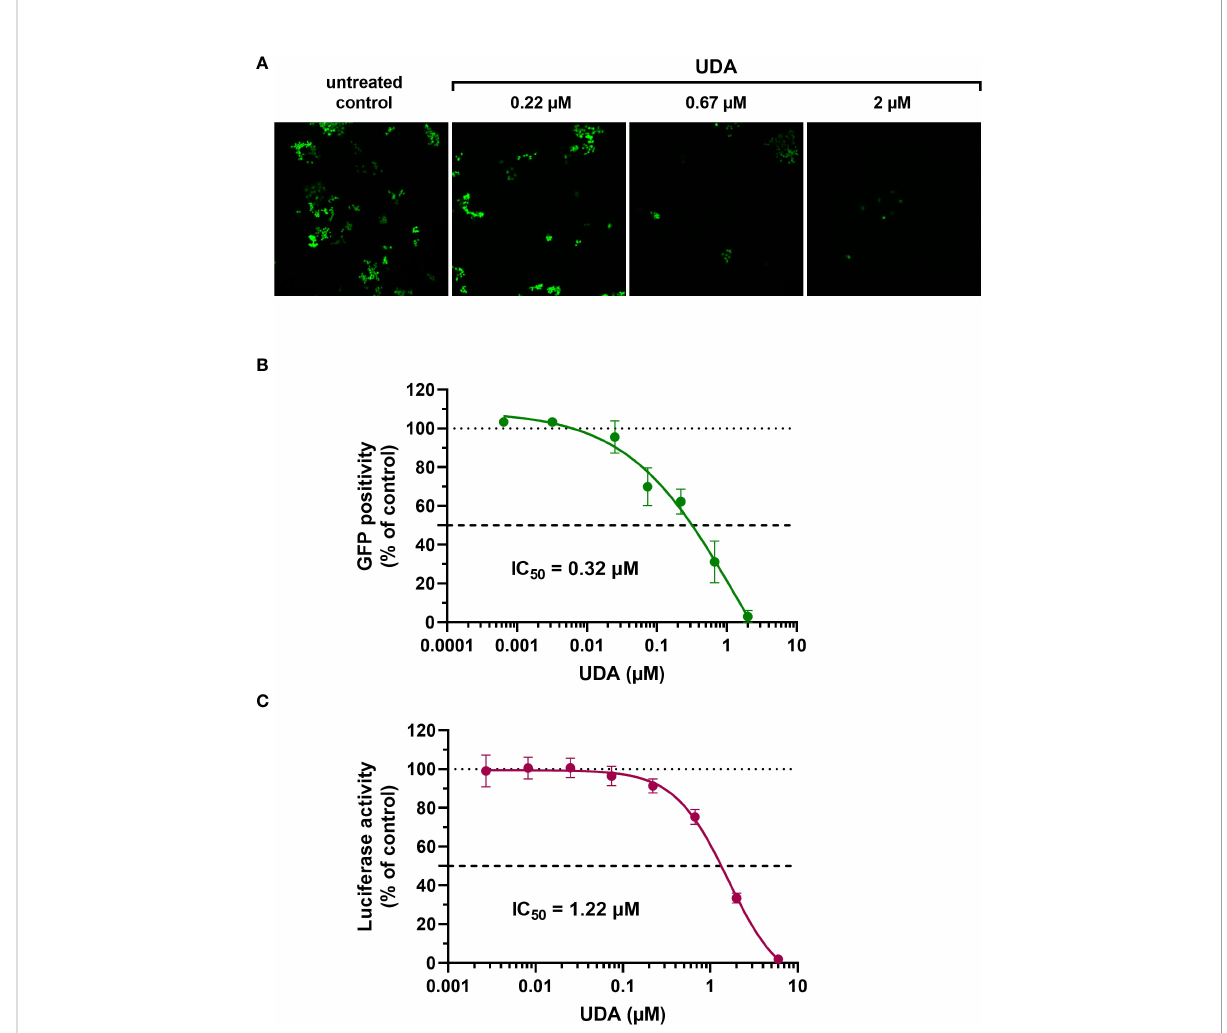
FIGURE 1 Antiviral activity of UDA against pseudotyped SARS-CoV-2. VLPs expressing the Wuhan-Hu-1 spike and a GFP or luciferase reporter was used to transduce cells in the absence (untreated control) or presence of UDA (as indicated). (A) A549.ACE2 + cells were transiently transfected with TMPRSS2 and subsequently exposed to pseudotyped SARS-CoV-2 expressing GFP. Panel shows representative images taken at 3 days post- transduction. (B) GFP-positive cells were quanti fi ed from images of (A) . Graph represents a concentration-response of UDA (mean ± SD from 3 independent experiments). (C) UDA was tested against luciferase-based pseudotyped SARS-CoV-2 in commercially available A549.ACE2 + .TMPRSS2 + cells. Luciferase activity was measured at 22h after VLP transduction. Graph represents a concentration-response of UDA from 3 biological replicates in quadruple (mean ± SD;